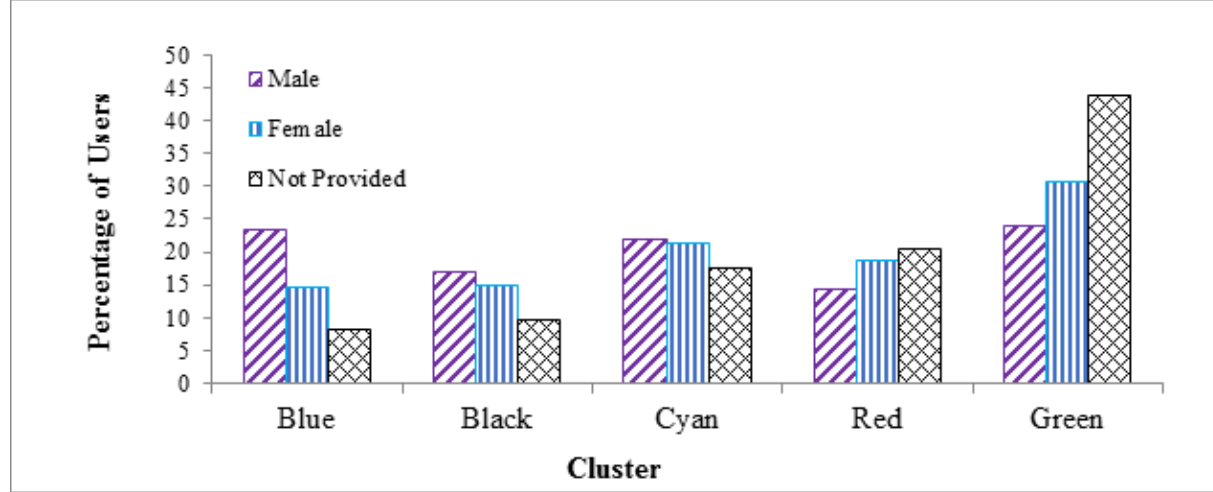
Figure 4. The distribution of users from each gender category across each of the 5 engagement